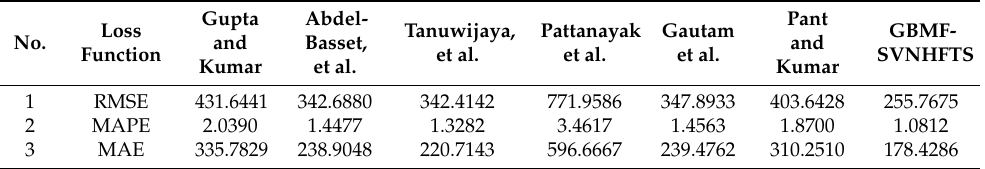
Table 2. A comparison of all three loss functions between the proposed GBMF-SVNHFTS method and other FTS